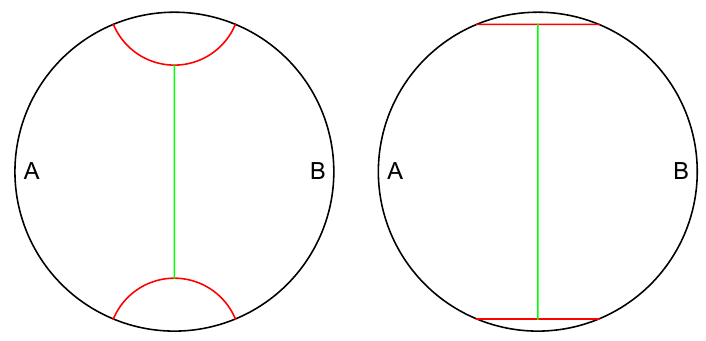
Figure 15. Left: plot of the RT surface (red) and the EP surface (green) in the Poincar(cid:19)e disk model. Right: the same plot as it appears in the BK